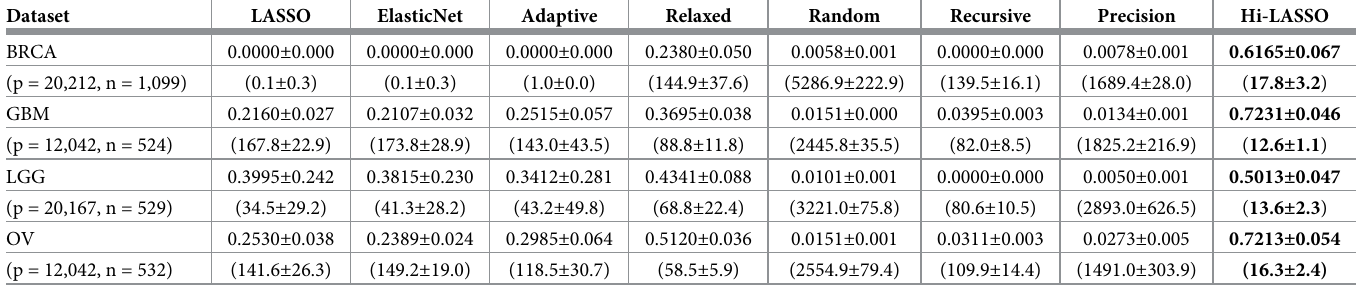
Table 2. Experimental results for feature selection performance (F1-scores and numbers of non-zero variables in parentheses) with the semi-simulated data based on four TCGA cancer datasets. The average of the experiments are shown, where bold-face indicates the best performance.